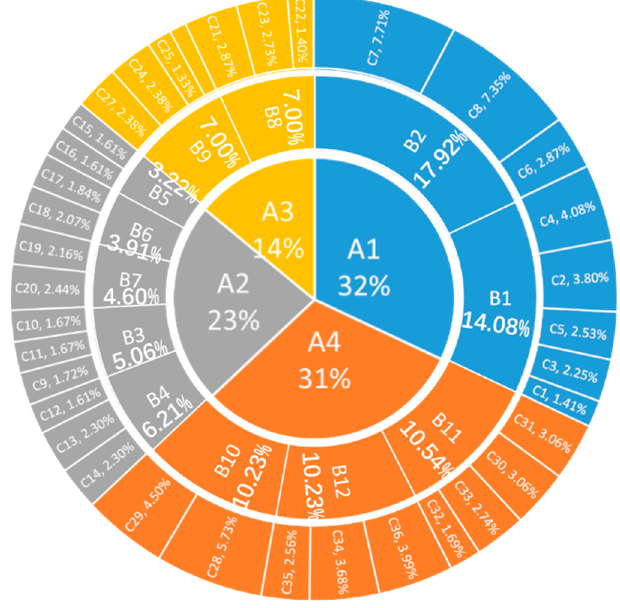
Figure 10. Weights of the city safety resilience index system.